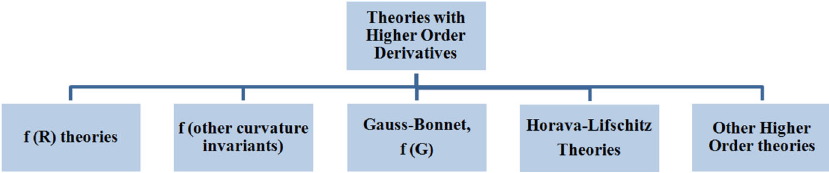
Fig. 13 Higher-order-derivatives modified gravity